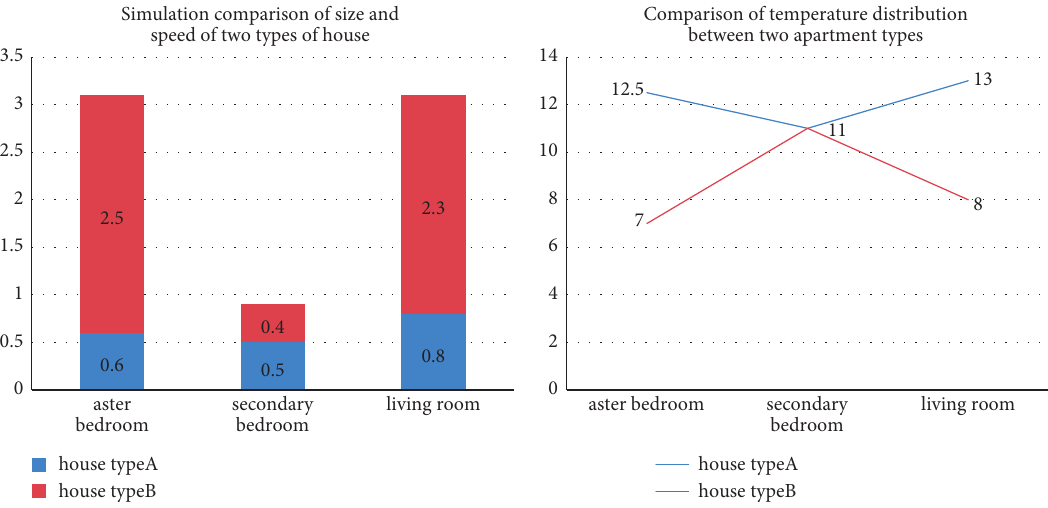
Figure 13: Condition 1: Comparison of speed and temperature distribution of two house types.